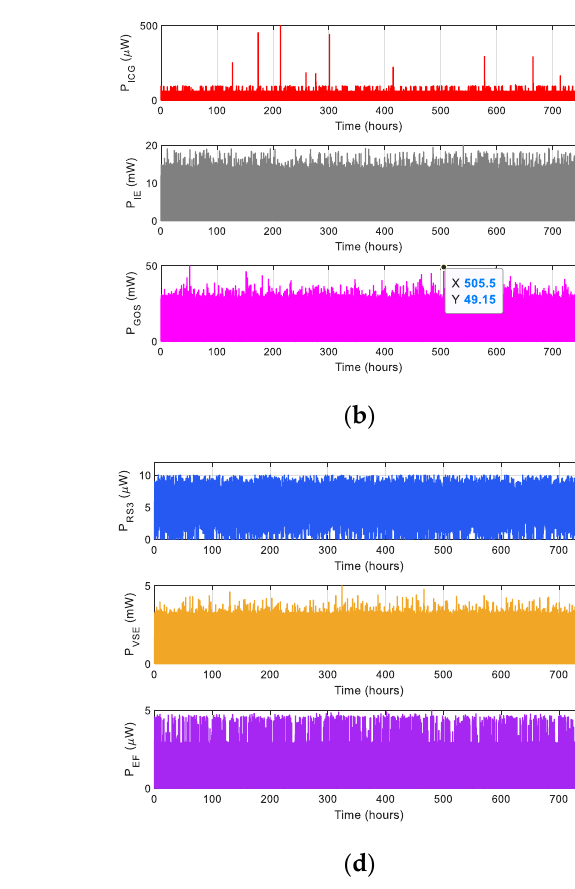
Figure 7. Fluctuations in the harvestable power at the different measuring points. ( a ) Harvestable powers on the Crusher Pinion and Crusher Gearbox (outlet). ( b ) Harvestable power on the Crusher Gearbox (Inlet), Internal Engine and Gearbox at the Output Side. ( c ) Harvestable power on the Gearbox Output SHaft, Radial Shaft 1 and Radial Shaft 2. ( d ) Harvestable powers on the Radial Shaft 3, Ventilation Side of the Engine and Engine Fan.